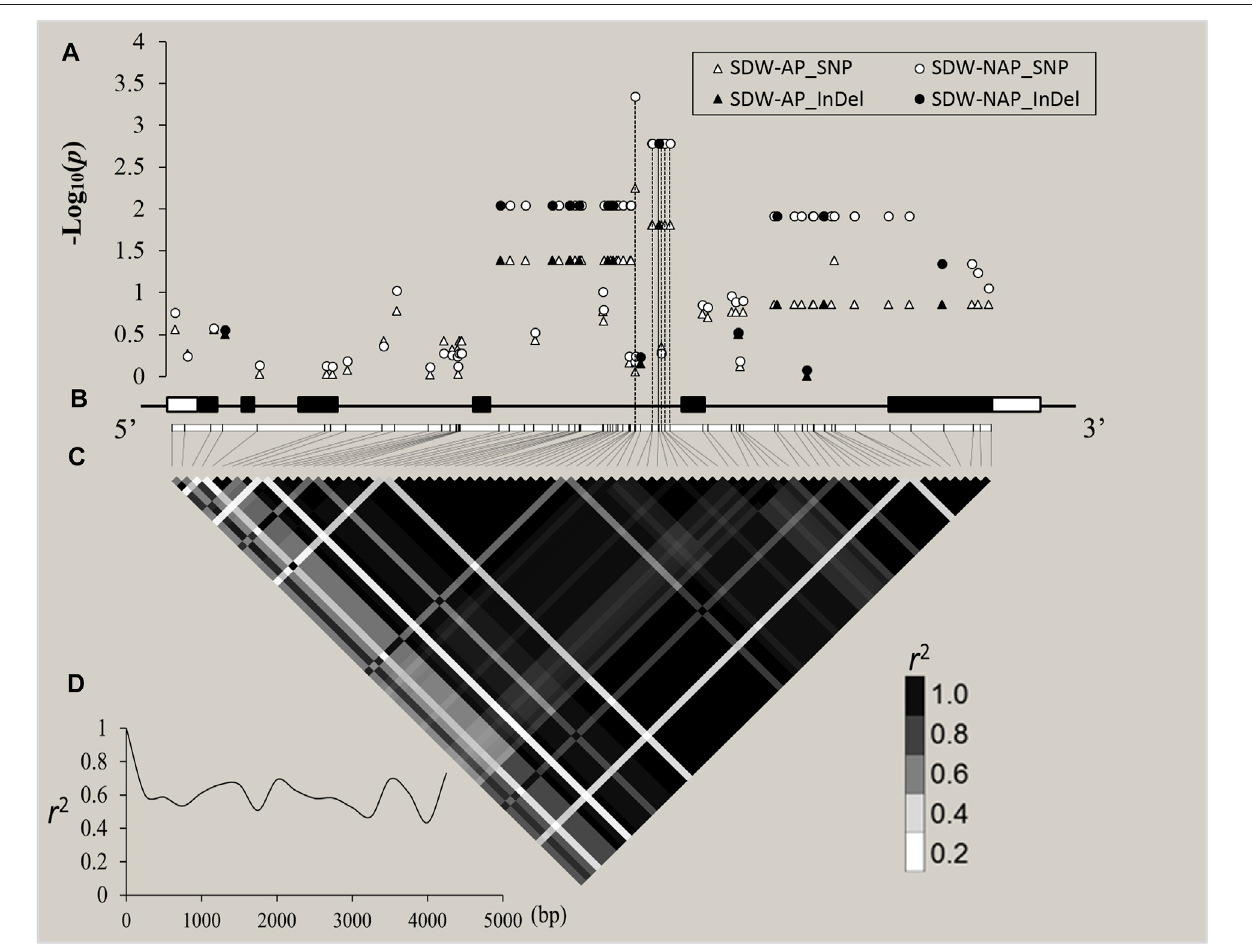
FIGURE5| ZmZFP126 -basedassociationmappingandlinkagedisequilibrium(LD)analysisin109diversemaizeinbreds. (A) :Thewhiteandblackshapes(triangle and circle)indicatedSNPs and Indel site, respectively. The p value isshown ona − log10 scale, and p ≥ 2isconsidered a signi fi cantsite. (B) : Aschematicdiagram ofthe entire gene structure is presented as the x-axis, including white and black boxes showing as UTRs and exons, respectively. C: The pattern of pairwise LD of DNA polymorphisms in the ZmZFP126 gene. The color re fl ects the level of LD ( r 2 ), and all polymorphic sites (MAF ≥ 0.05) are used. D: Decay speed of LD in the ZmZFP126 gene. The x-axis indicated a full-length